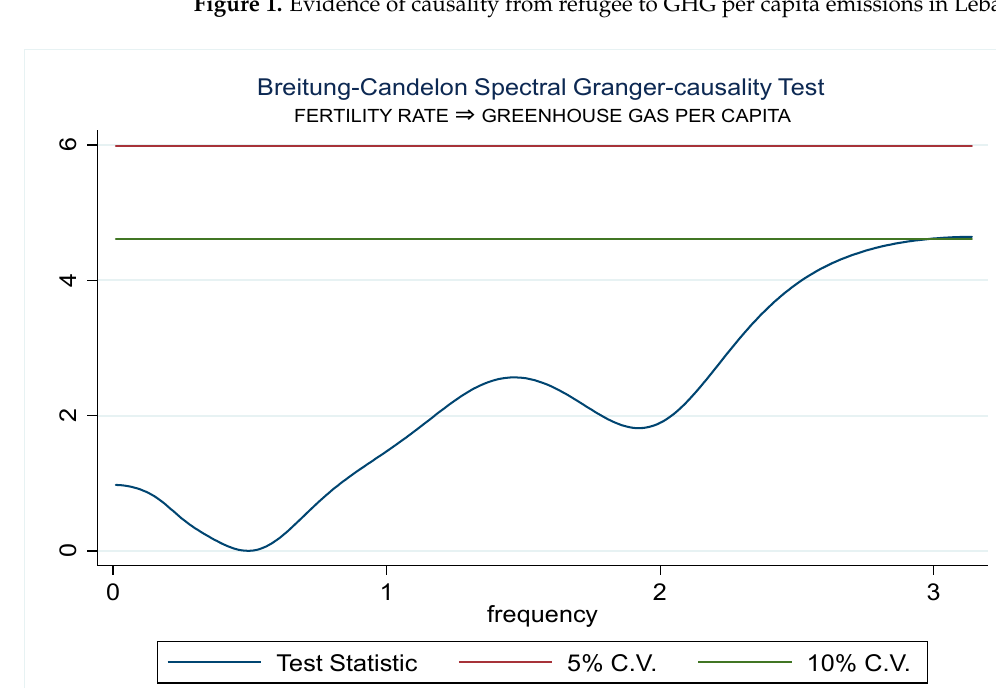
Figure 1. Evidence of causality from refugee to GHG per capita emissions in Lebanon.